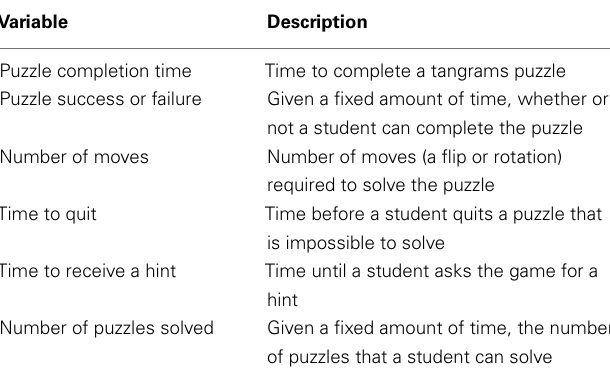
Table 4 | Candidate independent variables to explainTangrams performance.